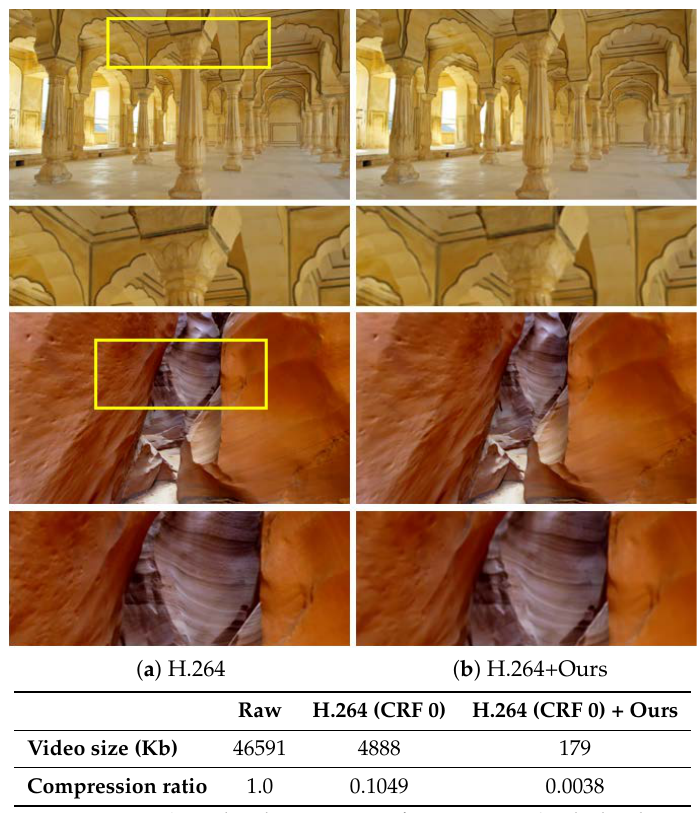
Figure 8. Comparison to video compression. Visual contrast between the ( a ) H.264 compressed frame and ( b ) our generated frame from H.264 compressed frame. In this experiment, different from Figure 7, we used the same CRF = 0 for comparing compression ratios. The magnified regions are denoted as yellow